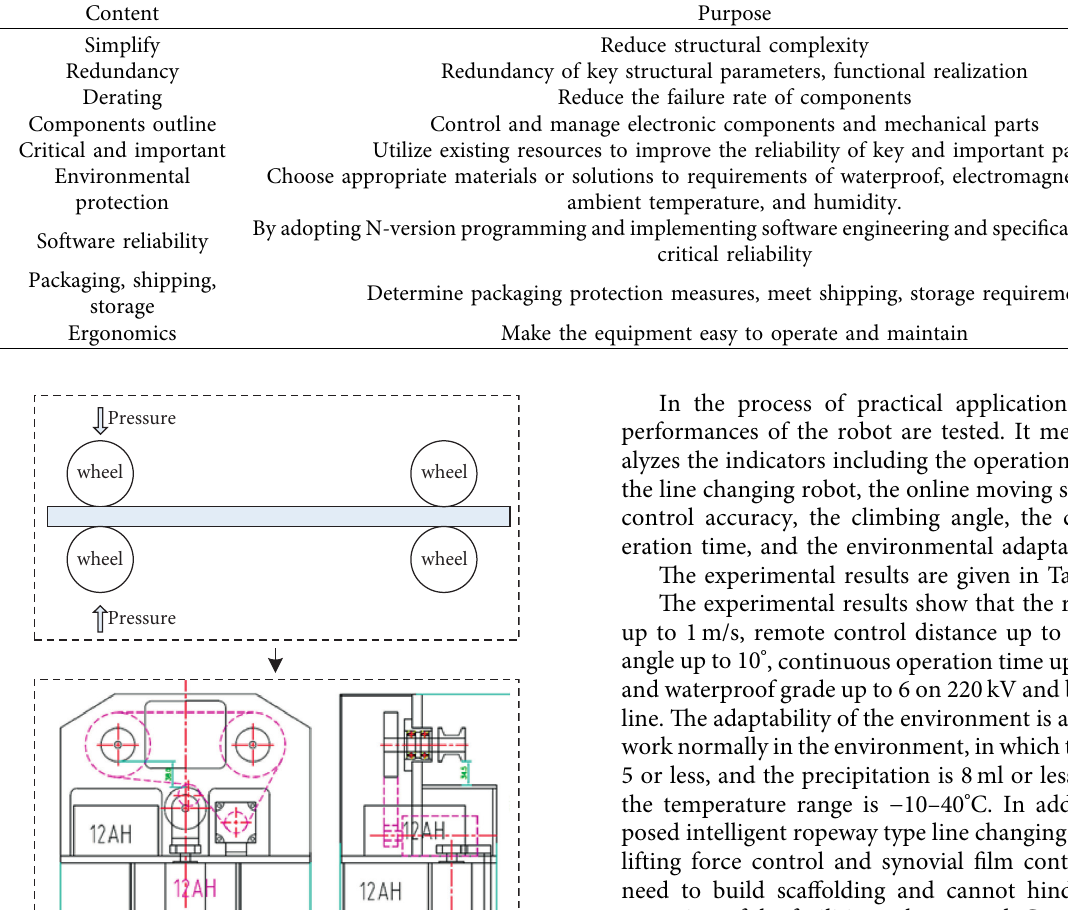
Table 1: The design content of the line changing robot.